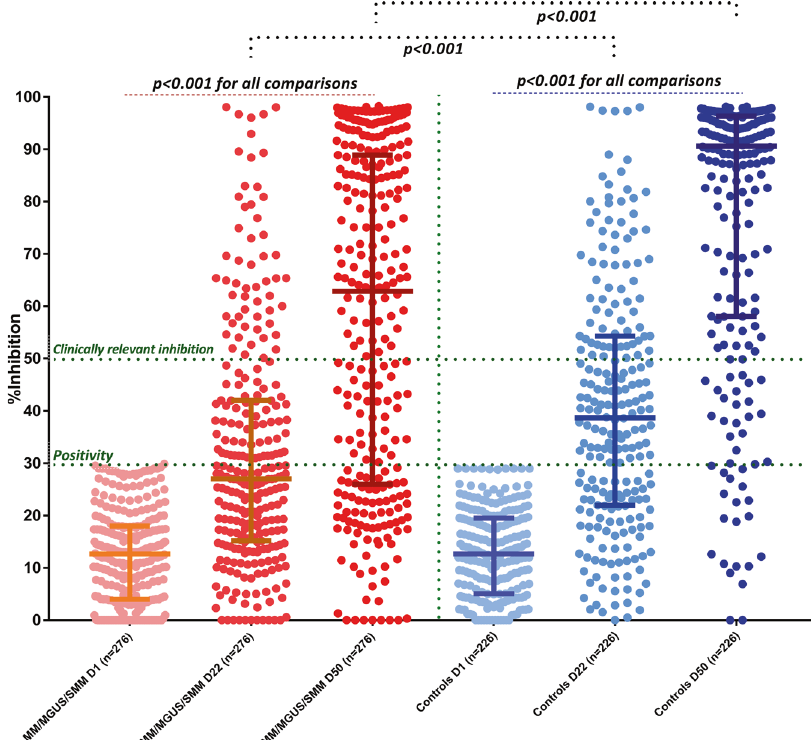
Fig. 1 Kinetics of NAbs in MM/SMM/MGUS patients compared with age- and sex-matched controls after vaccination with 2 doses of the BNT162b2 or 1 dose of the AZD1222 vaccine. Patients had signi fi cantly lower NAbs titers on day 22 and on day 50 compared with controls.